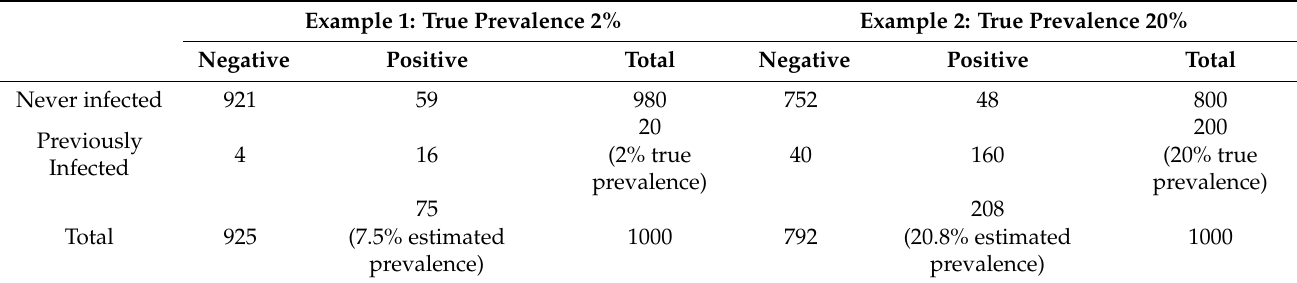
Table 1. Two examples of estimated seroprevalence using a test with sensitivity 80% and specificity 94%. Example 1: True Prevalence 2% Example 2: True Prevalence